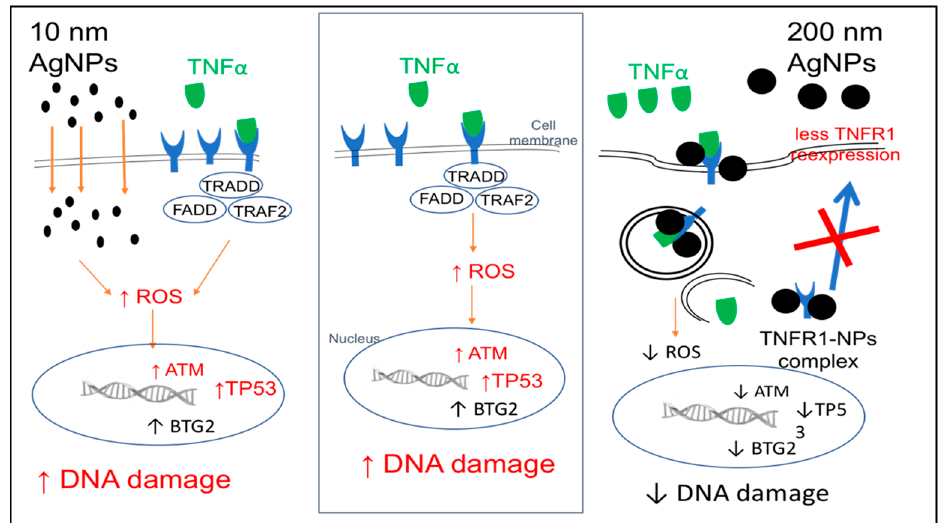
Figure 7. Proposed molecular mechanism explaining why TNF α -induced DNA damage was reduced by 200 nm AgNPs but not by 10 nm AgNPs, and how 200 nm AgNPs decreased membrane localization of TNFR1.